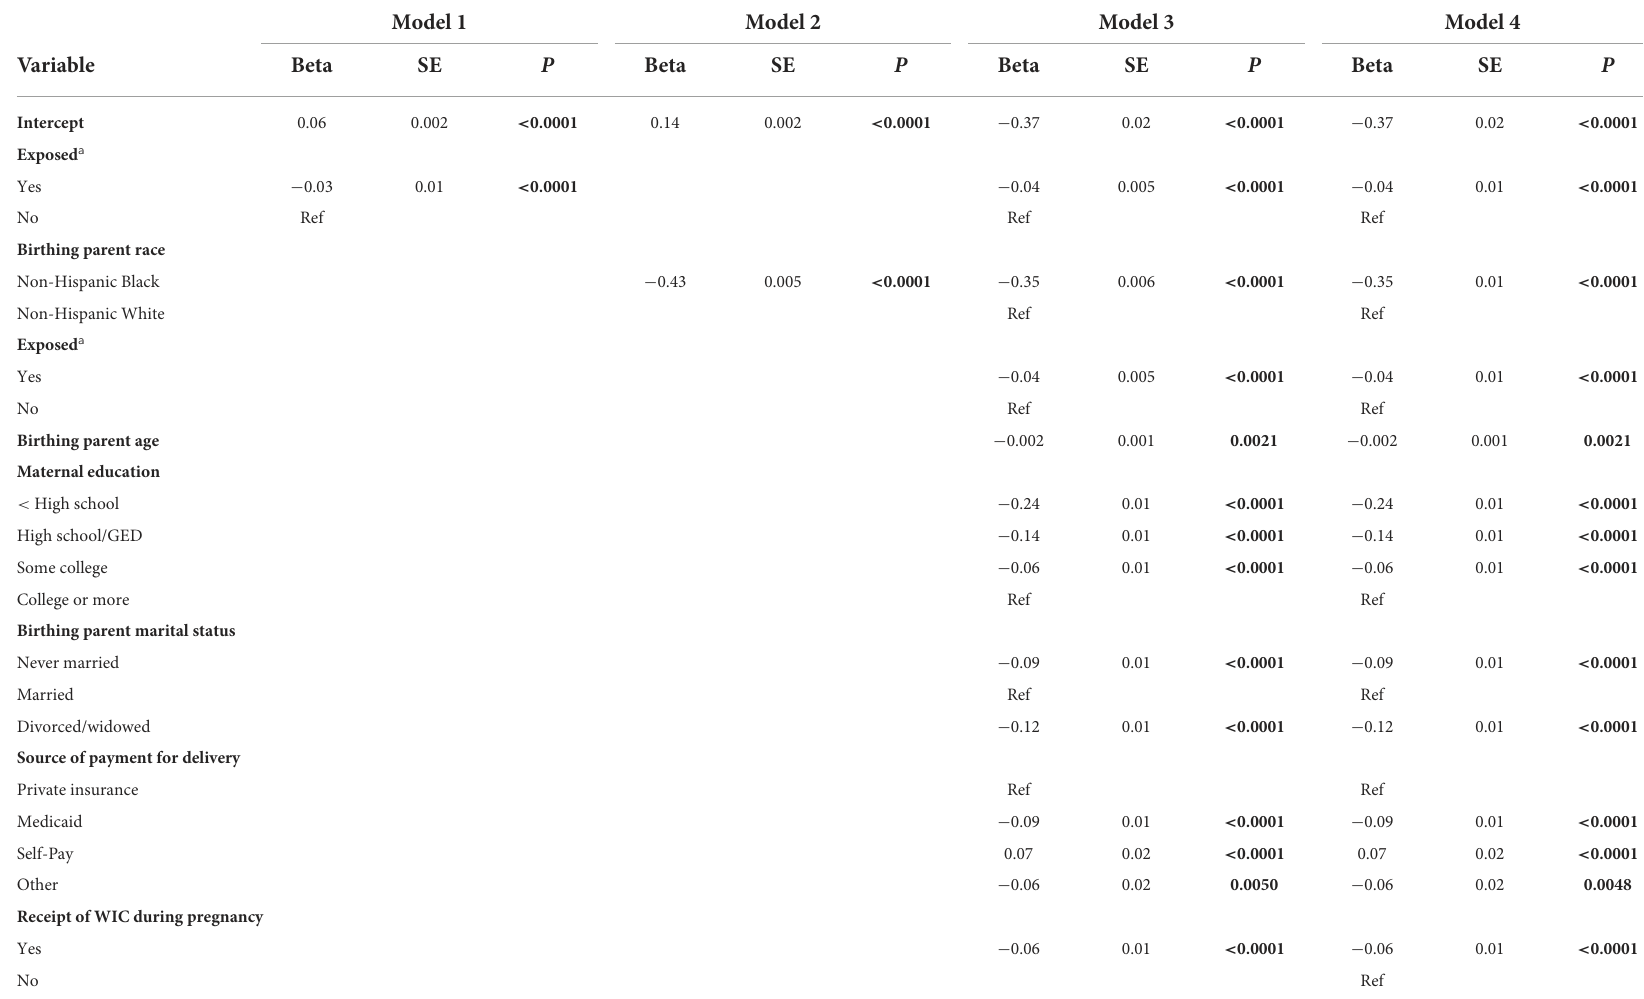
TABLE 4 Linear regression coefficients for regression of size for gestational age (z-score) on exposure to the Flint Water Crisis emergency declaration in Michigan ( n =